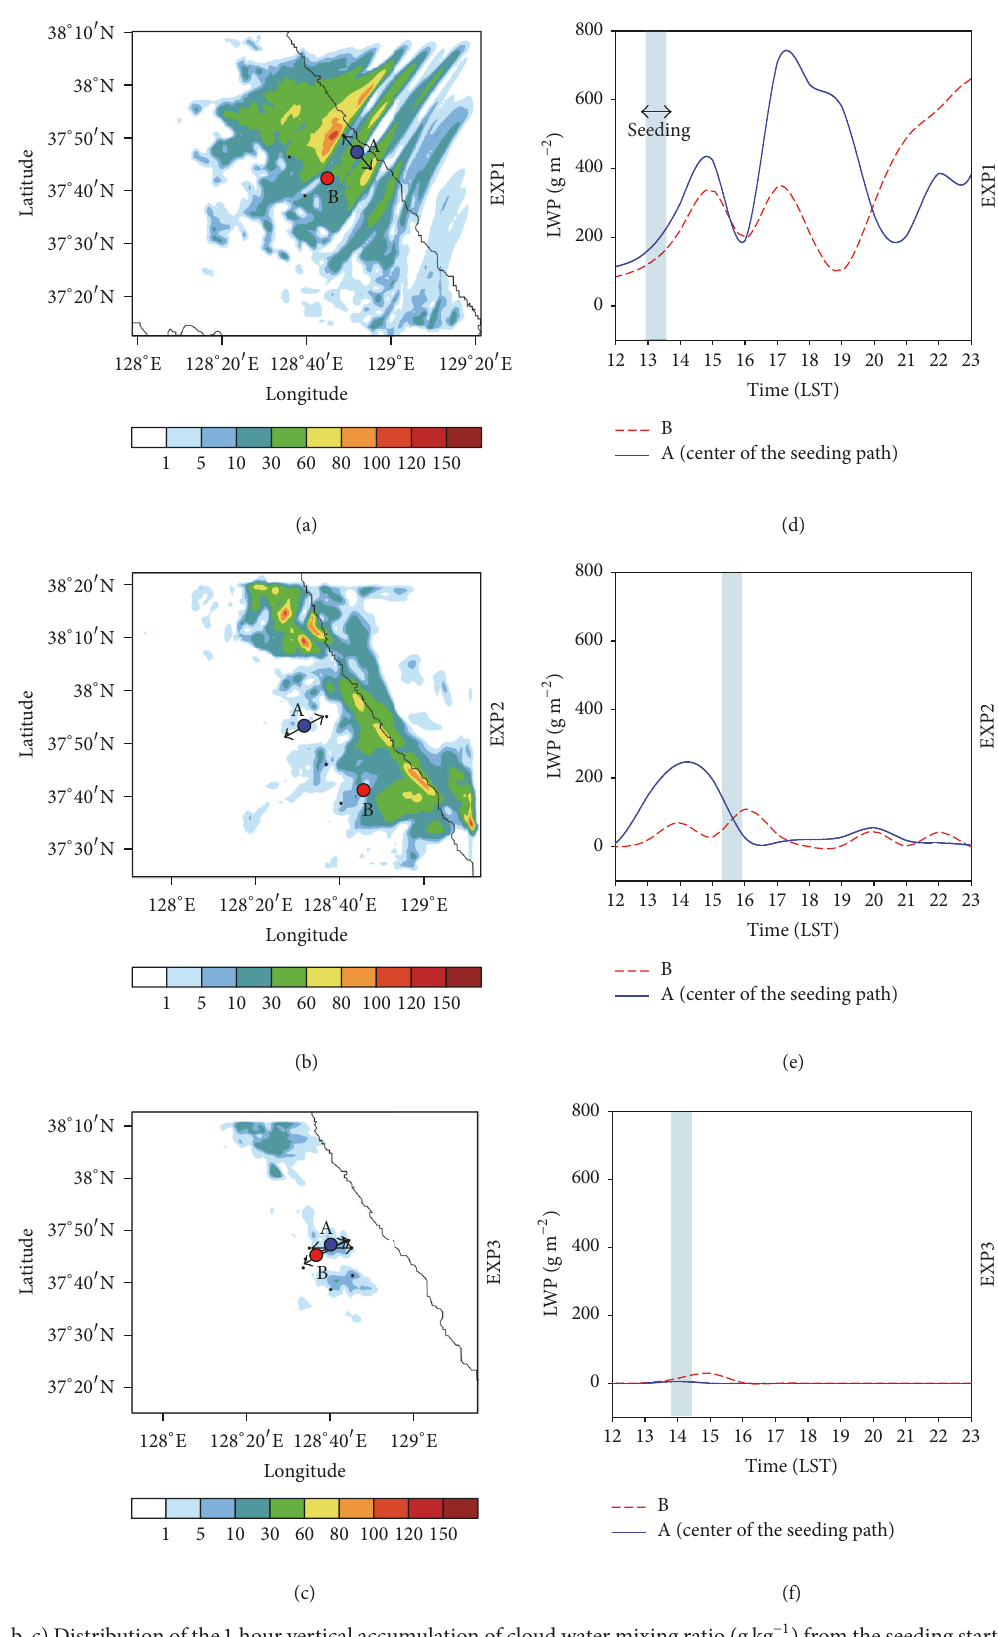
Figure 10: (a, b, c) Distribution of the 1-hour vertical accumulation of cloud water mixing ratio (g kg −1 ) from the seeding start time and (d, e, f) time series of the hourly liquid water path for the NOSEED simulation in EXP1 (a, d), EXP2 (b, e), and EXP3 (c, f). The blue and red lines in (d), (e), and (f) indicate the values at A and B in (a), (b), and (c),